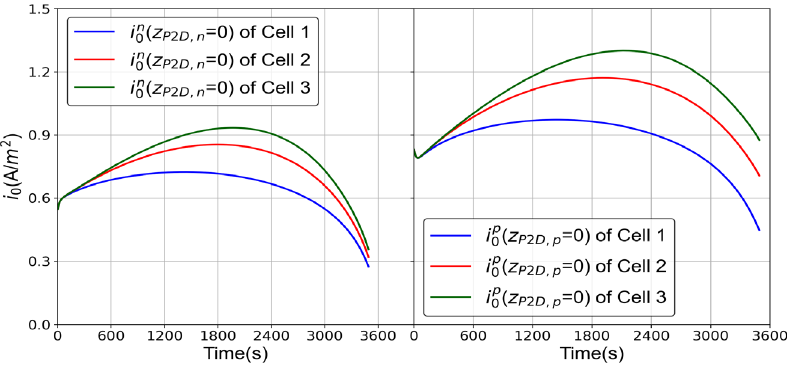
Figure 18. i 0 of PCBS_1 under the inhomogeneous cooling case 13. Table 10. Maximum local volumetric current density difference at the negative electrode (Δ j f,n,max_diff ) in the discharge process (10 4 A/m 3 ).